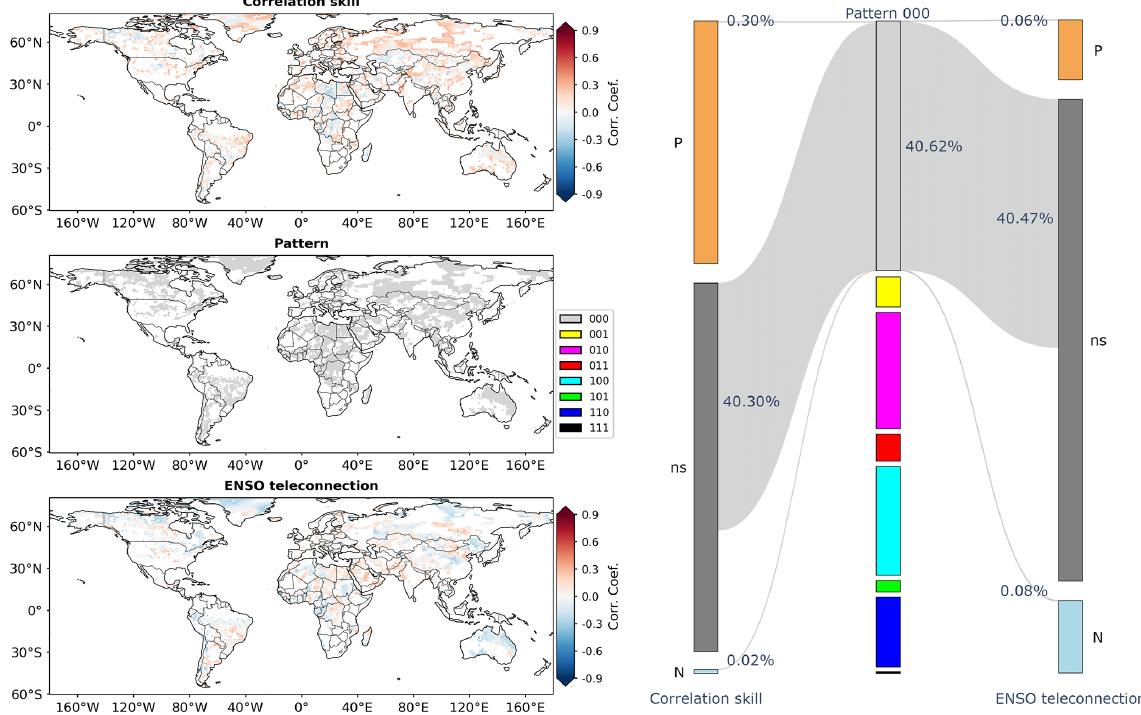
Figure 11. As for Fig. 4 but for pattern 000.